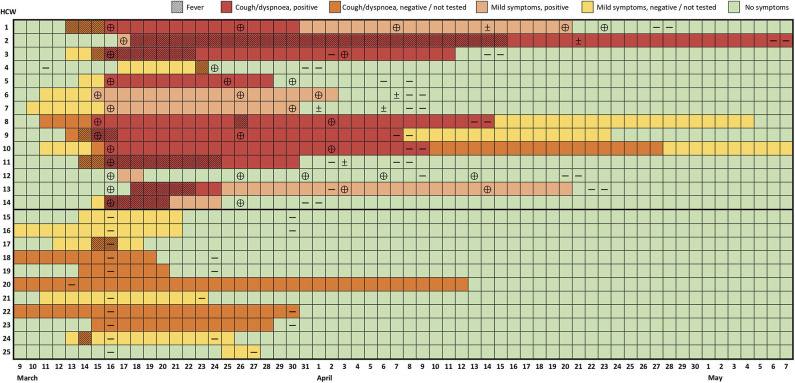
Evolution of symptoms and RT-PCR test results of healthcare workers with confirmed or suspected COVID-19. Each row represents a healthcare worker (HCW) followed over time (columns). Results of reverse transcription polymerase-chain reaction (RT-PCR) are indicated as positive (⊕), negative (—) or indeterminate (±). Mild symptoms include symptoms other than fever, cough, and dyspnea as referred to in the text and Table 1.